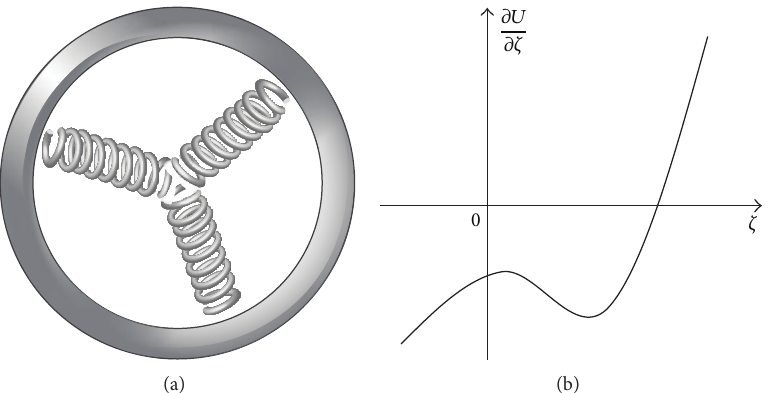
Figure 9: Left: sketch of the cross-section in a monolayered cylinder assumed. The effect of the coupling parameter 𝑘 is illustrated by virtual springs inside. Right: cubic curve of the 𝜁 -polynomial represented by 𝜕𝑈/𝜕𝜁 .